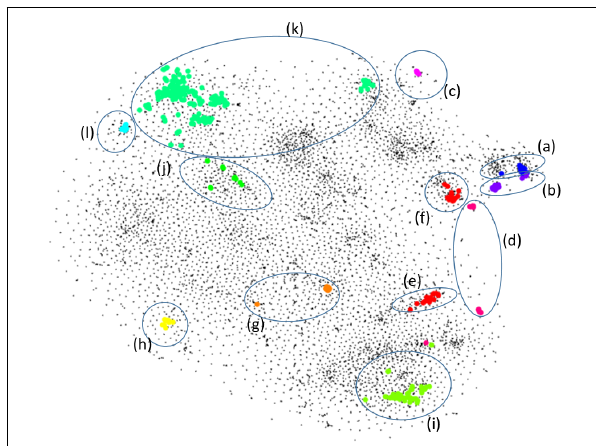
Figure 7. Clusters from DBSCAN in the 2D t-SNE embedding. The related time series are shown in Figure 8. The distribution on the building is shown in Figure 6.